Question: Produce a descriptive caption suitable for publication.
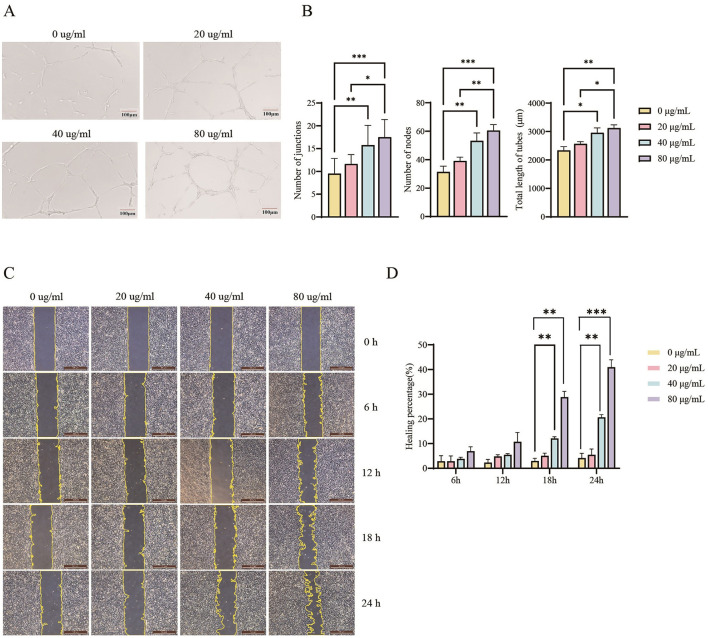
Answer: Biological function of 3D-EVs on angiogenesis and cell migration in vitro . (A) Images of the tube formation of 3D-EVs treated HUVECs for 8 h. (B) Quantification analysis of number of junctions, number of nodes and total length of tubes ( n = 3). (C) Images of 3T3 cell migration that treated with 0, 20, 40 and 80 ug/ml 3D-EVs for 0, 6, 12, 18, 24 h. (D) Quantification analysis of healing percentage. Continuous variables were described by means ± SEM. * p < 0.05, ** p < 0.01, *** p < 0.001.